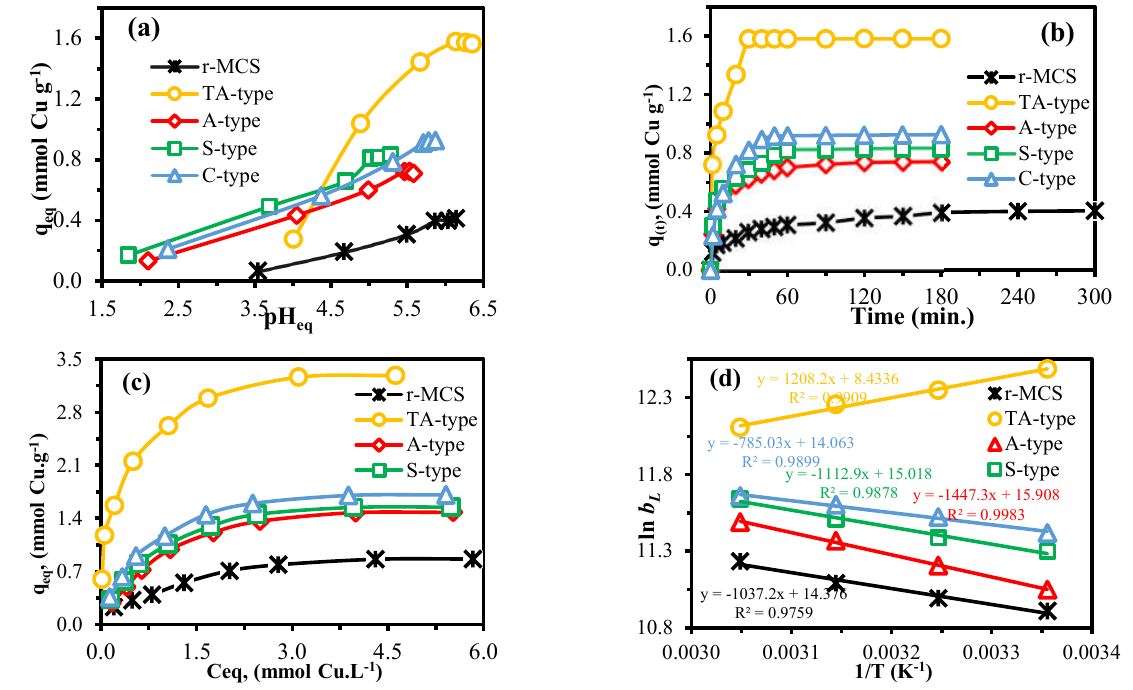
Figure 6. The pH effect ( a ), adsorption kinetics ( b ), isotherms ( c ), and thermodynamics ( d ).